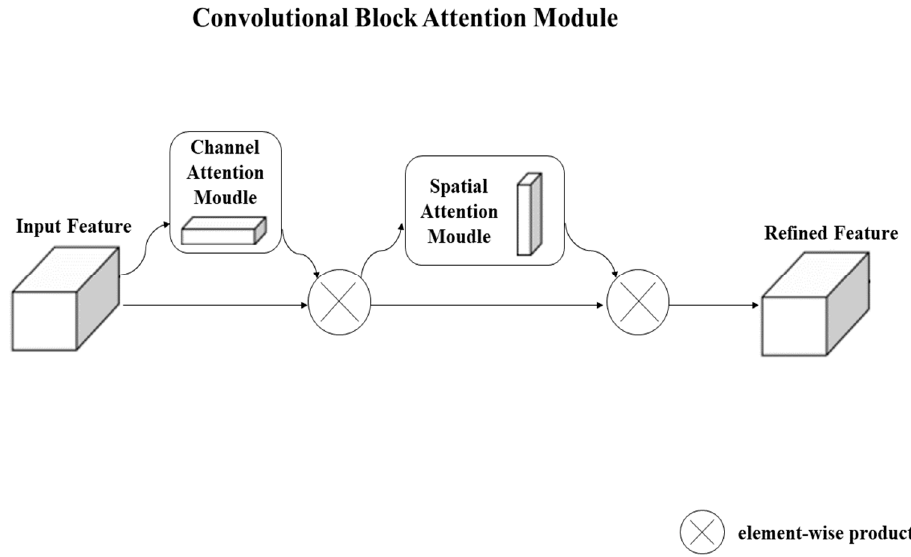
Figure 3. A tt ention model. Figure 3.